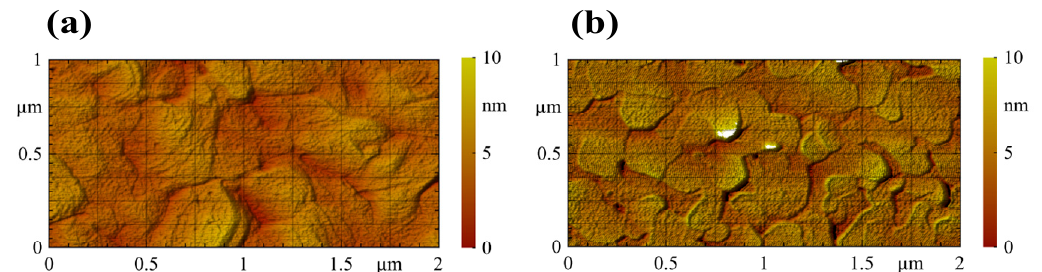
Figure 5. AFM images [38] of ( a ) the Al wafer surfaces for standard deposition, ( b ) the Al wafer surfaces for the ALPS wafers.